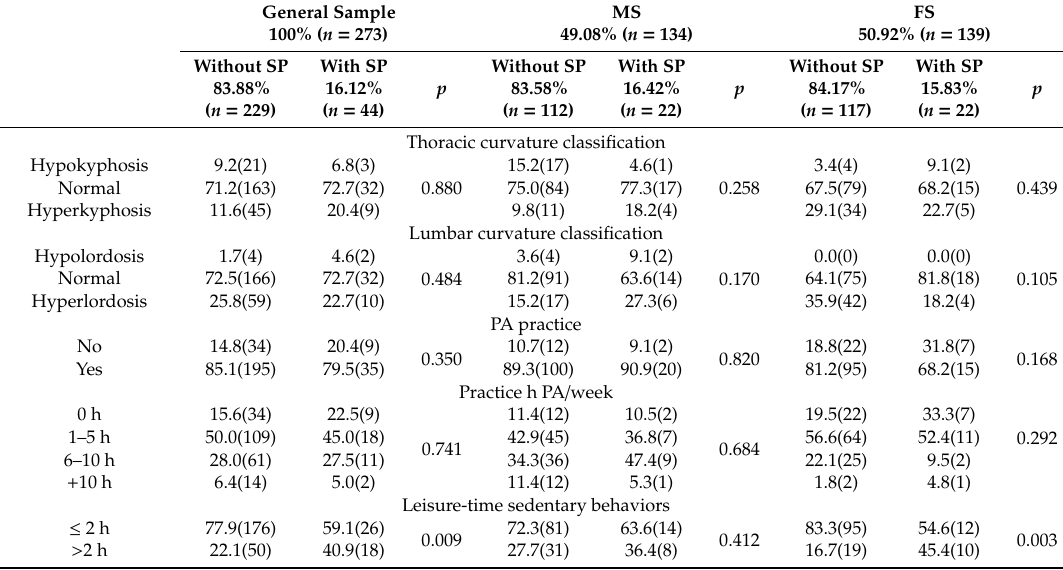
Table 4. Percentages (counts) of curvatures classification, PA and leisure-time sedentary behaviors and di ff erences between SP and sex.